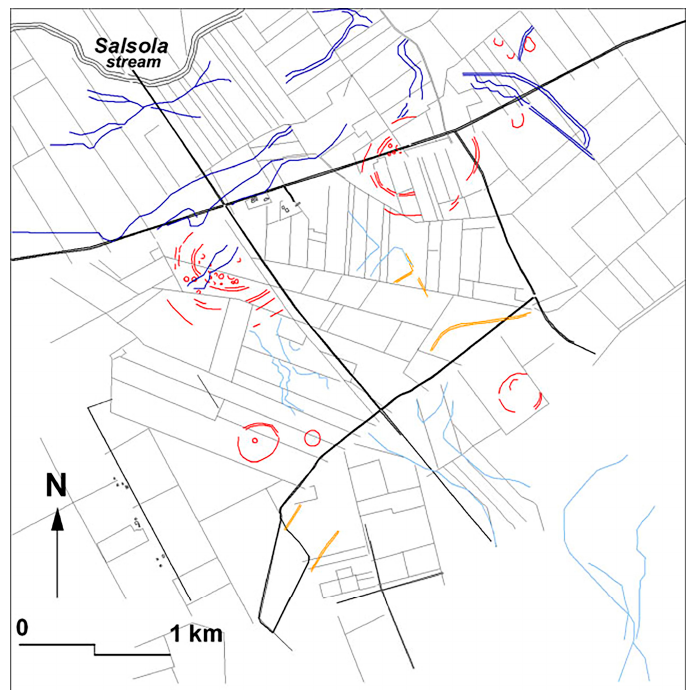
Figure 6. Typical Neolithic settlements in the Tavoliere delle Puglie: ( a ) settlement of Masseria Schifata; ( b ) settlement of Passo di Corvo [36]. Figure 6. Example of evidence of the ancient landscape and archaeological remains in Apulia: (i) blue lines represent palaeoriver; (ii) red lines represent the Neolithic settlements of Palmori and Schifata; (iii) orange lines represent roads; (iv) light blue lines represent hydromorphic marks related to an ancient marshy environment; (v) black and grey lines represent modern roads, channels and fields ([14], Figure 5).